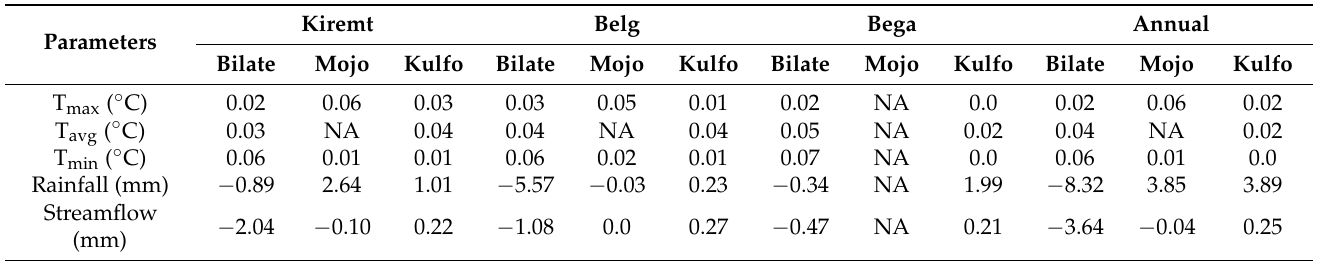
Table 8. Comparisons of M–K test results for temperature, rainfall, and streamflow in the Bilate, Kulufo, and Mojo watersheds. Kiremt Belg Parameters